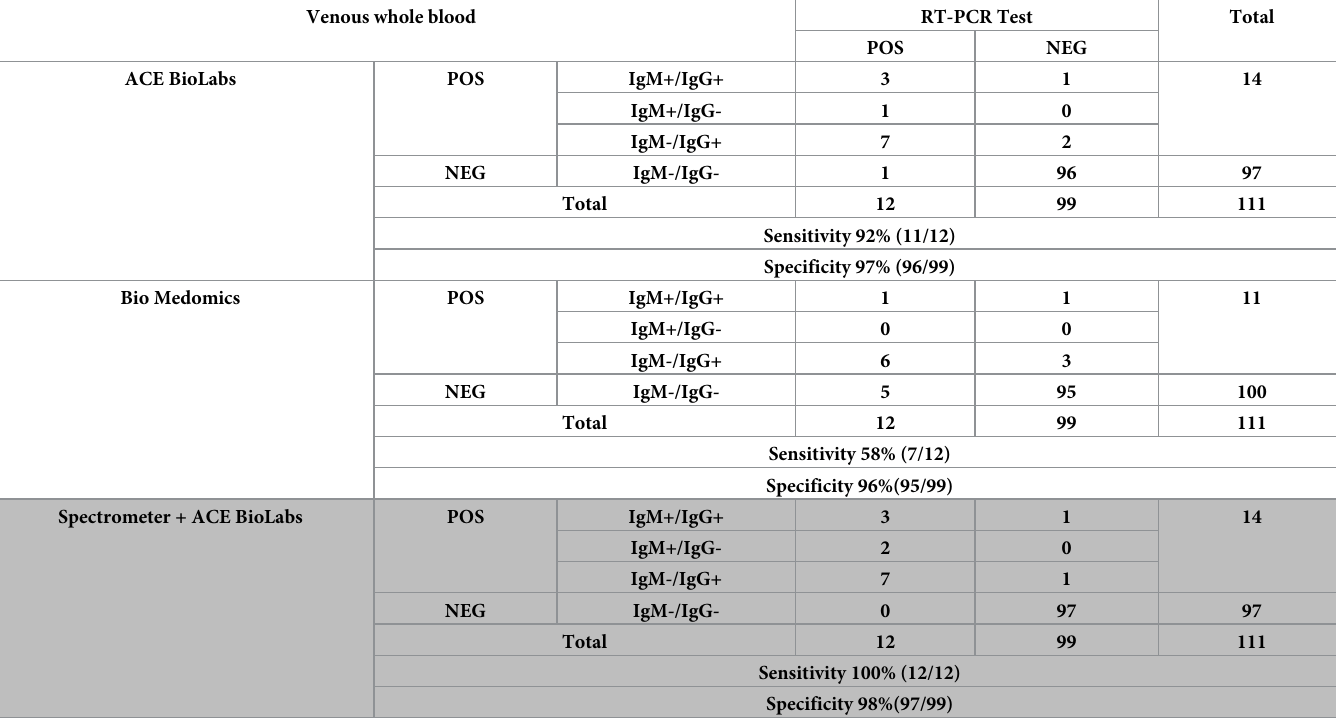
Table 4. COVID-19 IgG/IgM antibody rapid